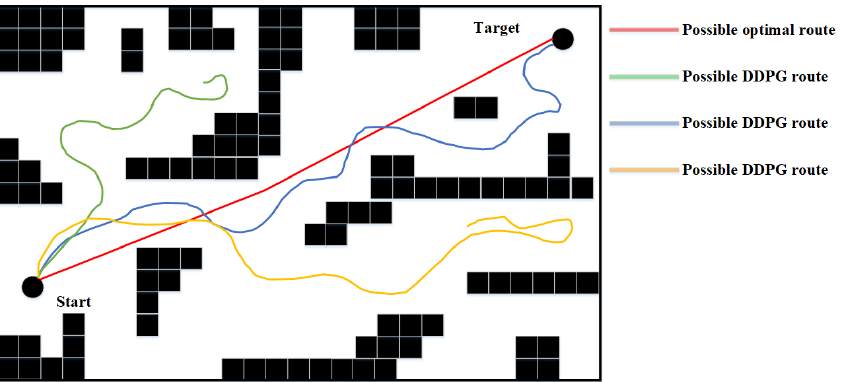
Figure 2. Problem of DDPG Path Planning in Large